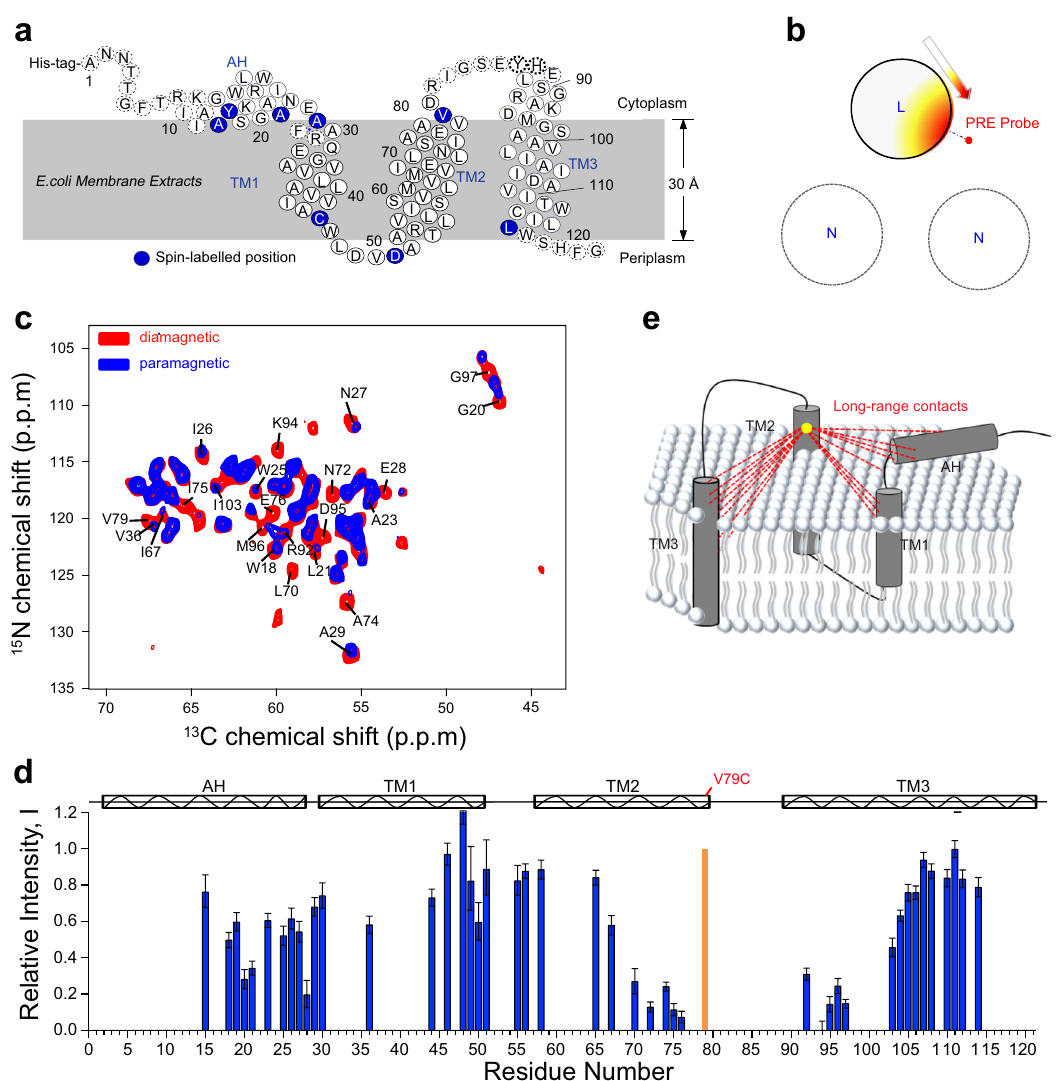
Fig. 3 Extraction of intra-monomer distance restraints from PRE measurements using diluted samples. a Eight spin-labeled sites (shown as blue balls) for the intra-monomer PRE measurements. b Labeling method for observing intra-monomer PREs by spin dilution (see Fig. S11 for more details). “ L ” and “ N ” represent uniformly 13 C, 15 N-labeled and naturally abundant monomers, respectively. c Superimposition of the 2D NCA ssNMR spectrum of the paramagnetic sample, 13 C, 15 N-MTSL-V79C-DgkA/na-wt-DgkA (blue), on that of the diamagnetic cysteine-free sample, 13 C, 15 N-C46A-C113A-DgkA (red). The peaks with a large attenuation are labeled. d Intra-monomer PRE contacts observed for DgkA with a spin-label at the V79C residue. Relative intensity I (given by Eq. 1) calculated from the height of cross-peaks in the NCA spectra of paramagnetic and diamagnetic samples (see panel ( c )) is plotted for each residue with an observed PRE effect. The noise levels of the corresponding peaks were shown by error bars. The secondary structure of DgkA identi fi ed by the ssNMR chemical shifts is shown on the top. The spin-labeling site at V79C is highlighted in orange. e Intra-monomer long-range (|i-j| > 5) electron – nuclear distances (dashed lines) obtained from the PREs measured in DgkA mutant with a spin-label site at the V79C (yellow